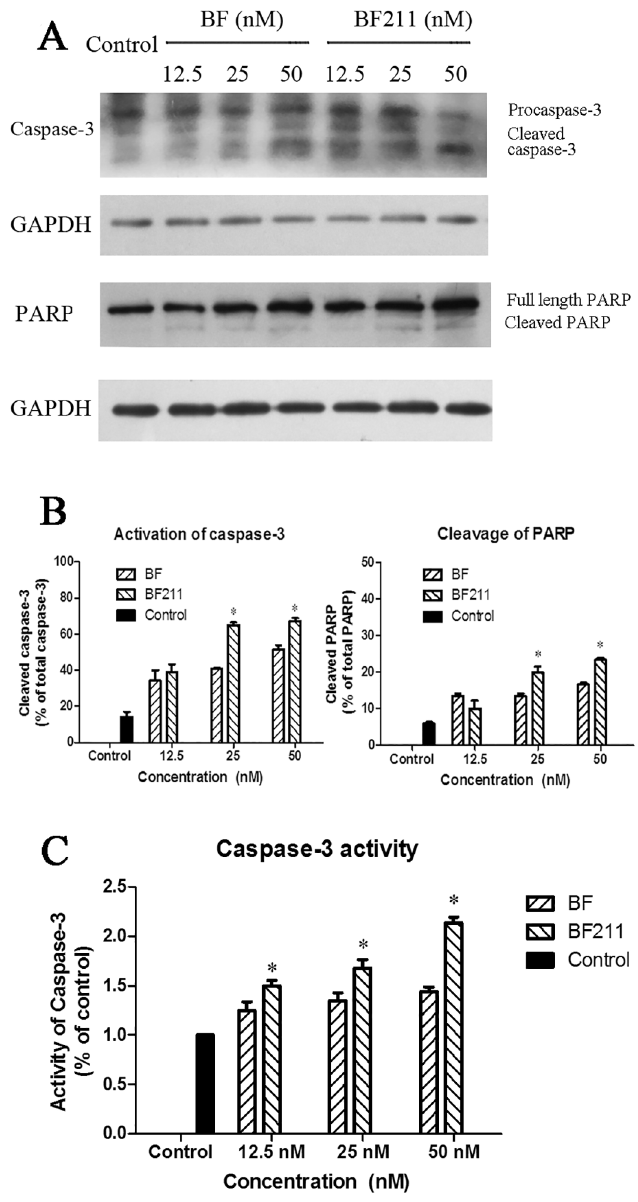
Fig 6. Effects of BF or BF211 on caspase-3 activation and PARP cleavage in A549 cells. (A) The r epresentative western blot assay results probing the levels of caspase-3 and PARP in cells treated with BF or BF211 at different concentrations for 24 h. (B) The quantification of the western blot assay results of the activation of caspase-3 (percentage of cleaved caspase-3 from the total caspase-3) and cleavage of PARP (percentage of cleaved PARP from the total PARP) in cells treated with BF or BF211 at different concentrations for 24 h. The data are the statistical results (n = 3, mean ± SEM) of three independent experiments. * p < 0.05 vs. BF-treated group. (C) The activity of caspase-3 in cells treated with BF or BF211 at different concentrations for 24 h. The data comprise the statistical results (n = 3, mean ± SEM) of three independent experiments. * p < 0.05 vs. BF-treated